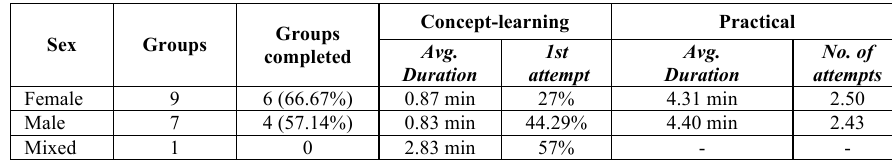
Table 4. Comparing the performance categorized by players